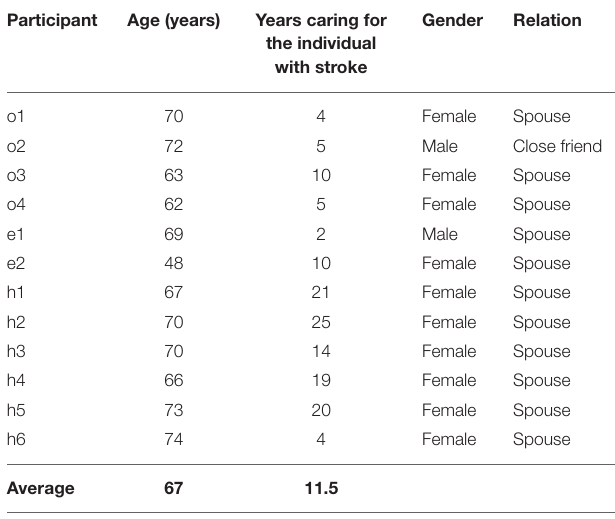
TABLE 3 | Participant demographics—Informal caregivers of individuals with stroke ( N =